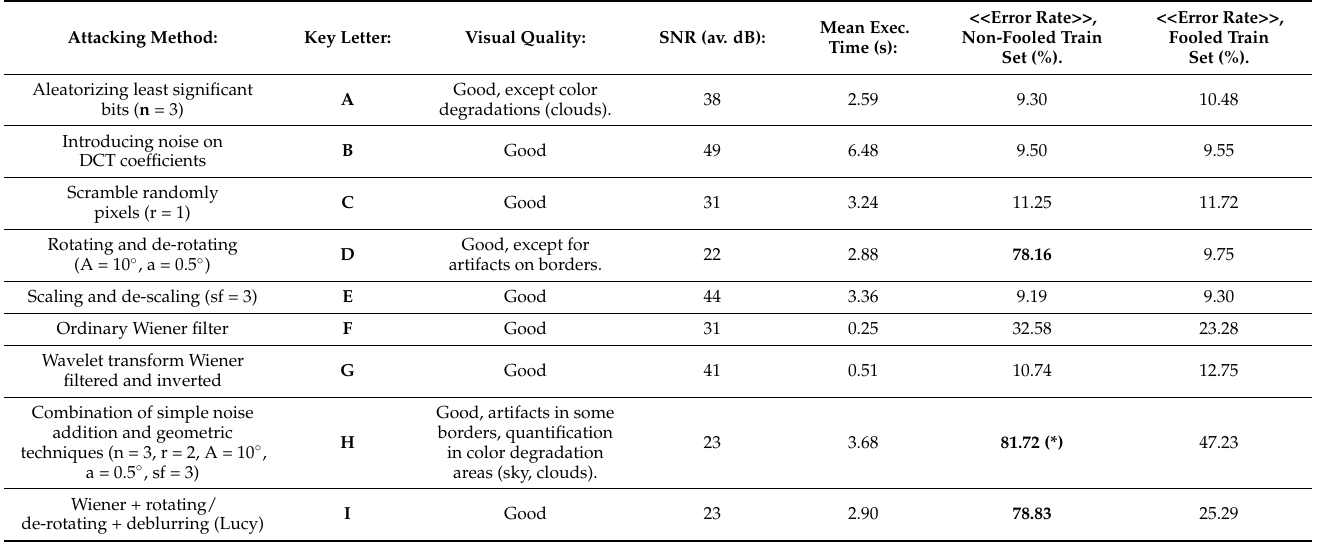
Table 2. Summary of test results (original error rate: 9.09